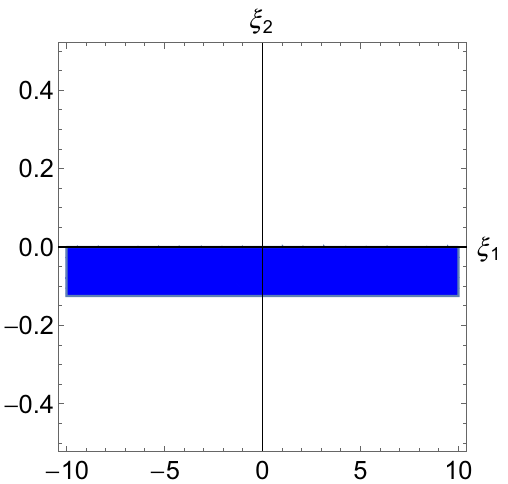
Fig. 4 The non-exclusive saddle regions where the P 6 + critical point representsasaddlecosmologicalepoch( [ 3 ] < 0 , E [ 4 ] > 0) P 3 3